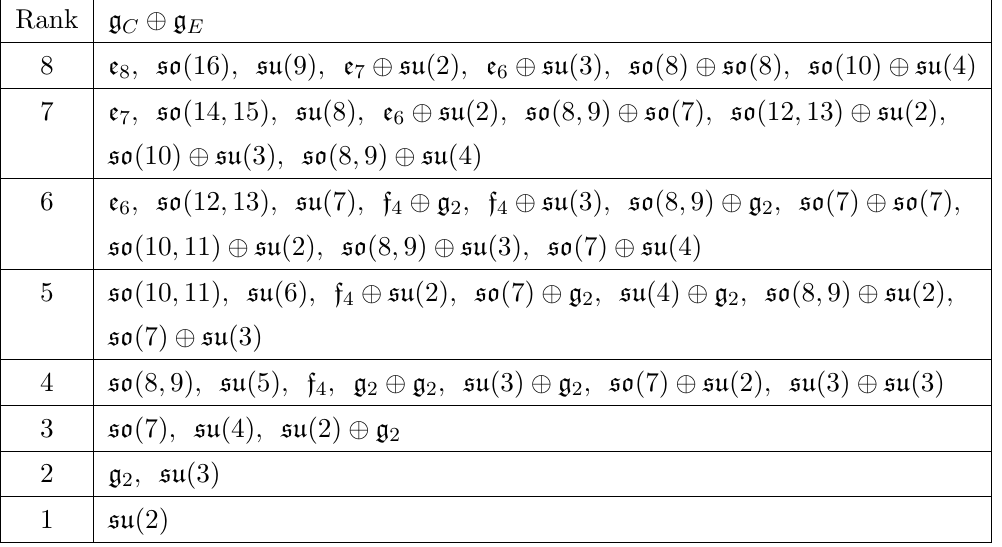
1 curve carrying sp (cid:0)